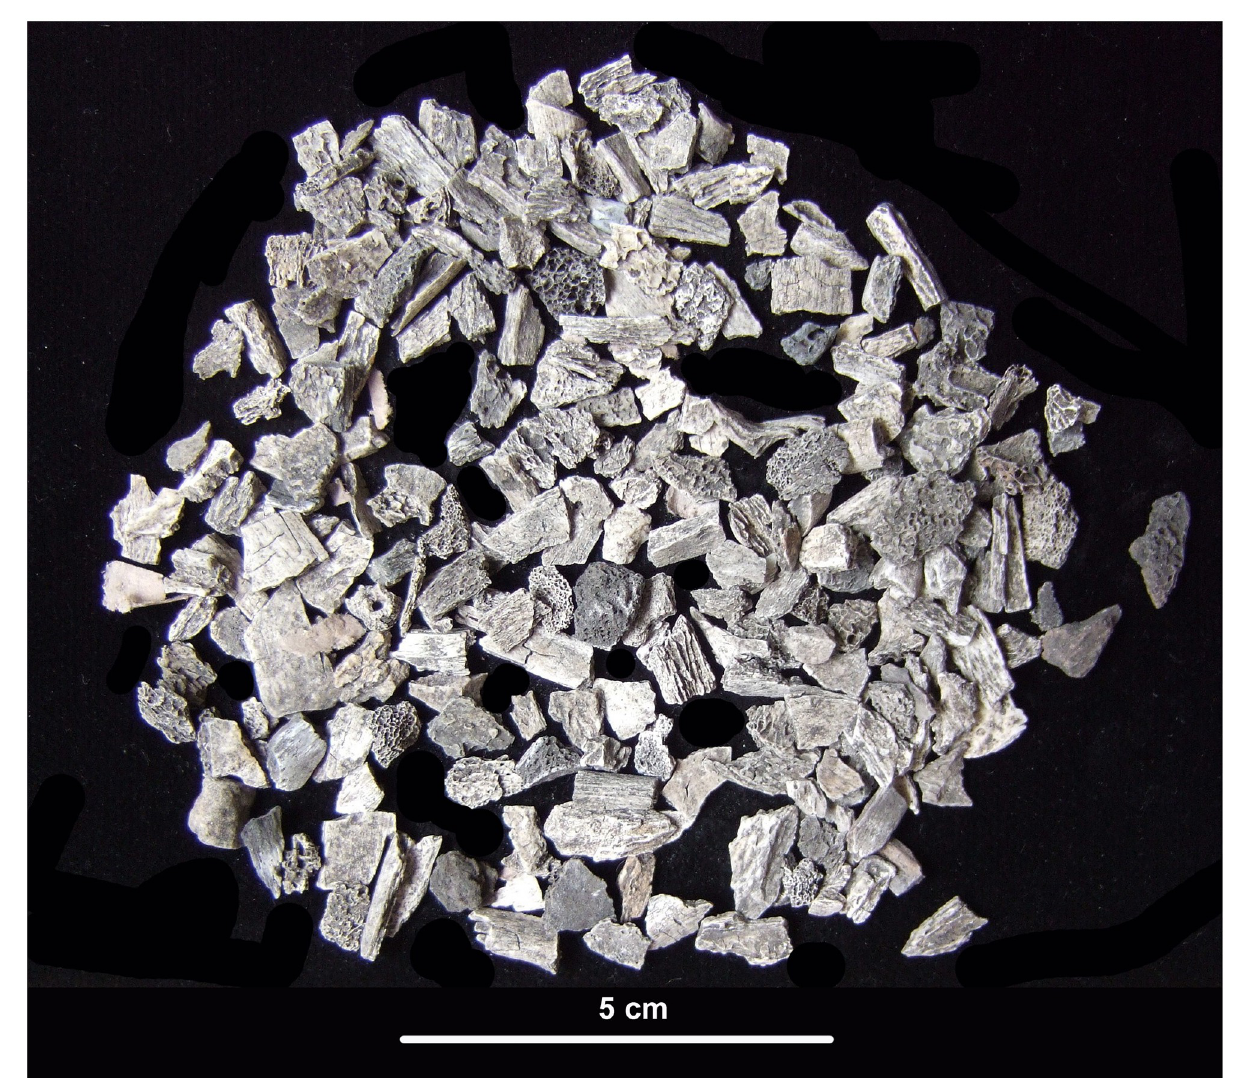
Fig 3. Sample of cremated bones from feature ‘US